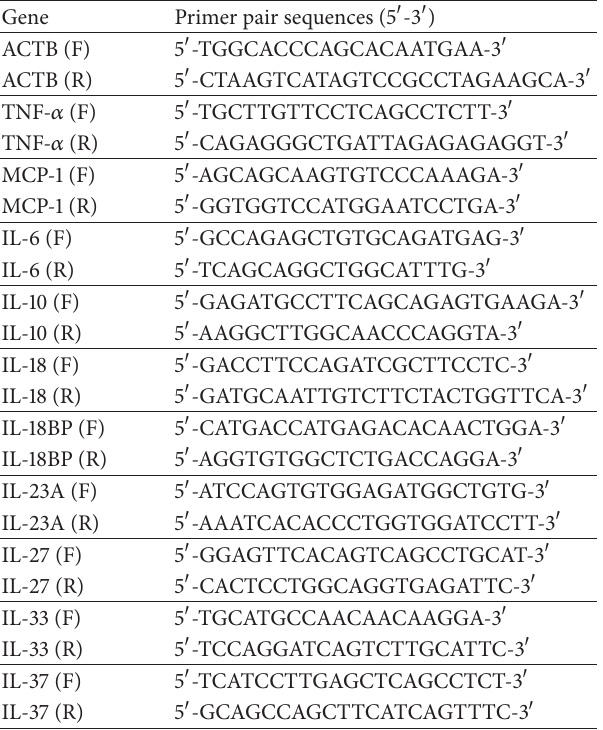
Table 1: Primer sequences for real-time quantitative polymerase chain